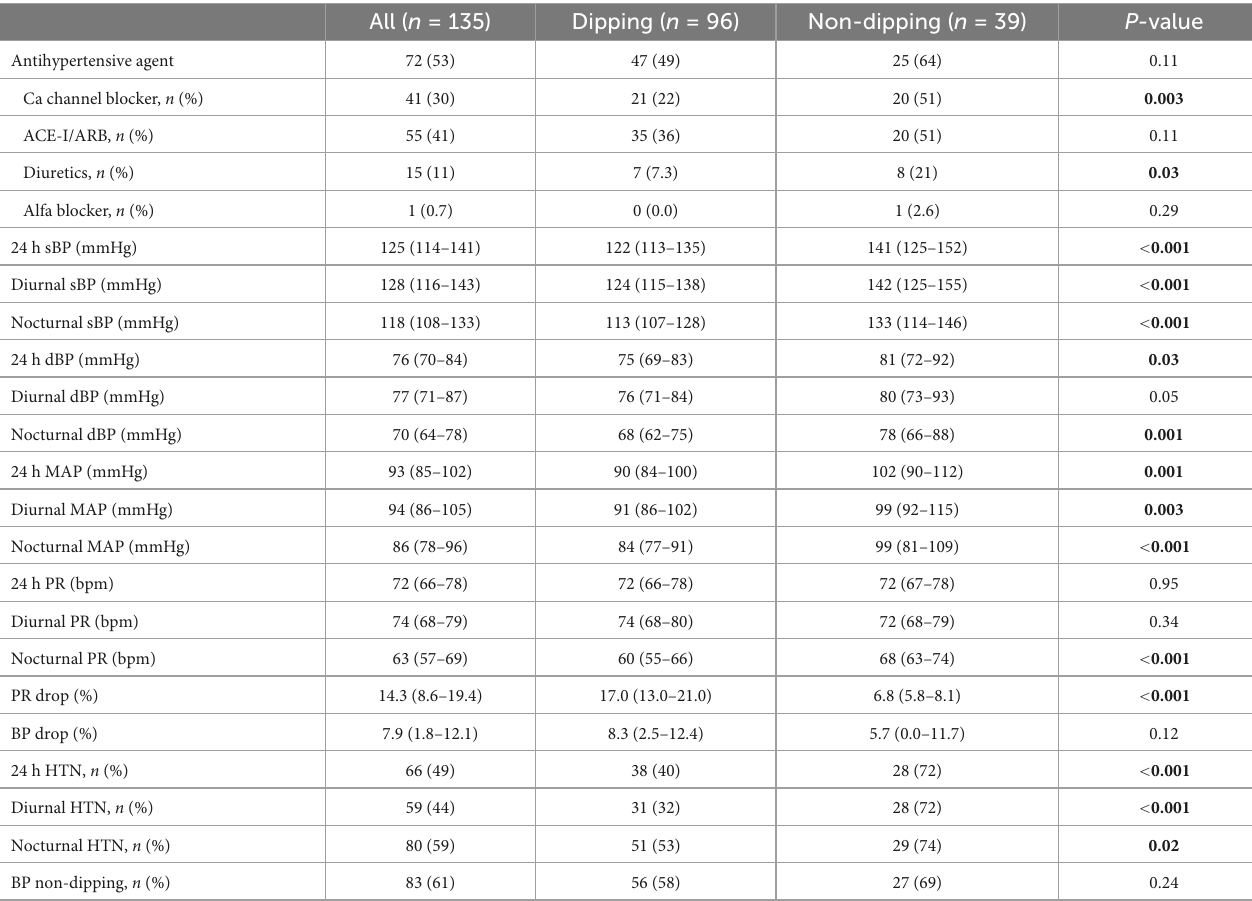
TABLE 2 Ambulatory blood pressure monitoring measurements of the subjects according to the dipping and non-dipping pulse rate pattern. All ( n = 135)